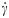
Experimental data represented in terms of the rescaled pressure, σrs, as defined in Eq (14), and the shear rate, γ˙.Plotting the experimental results in terms of these variables enables us to directly estimate the viscosity of the fluids (water (red squares), blood plasma (blue triangles), and ethylene glycol at 44% dilution (green circles)) as shown in Eq (15). We have used two capillaries with different heights: b = 150 μm (empty symbol) and b = 300 μm (solid symbol).